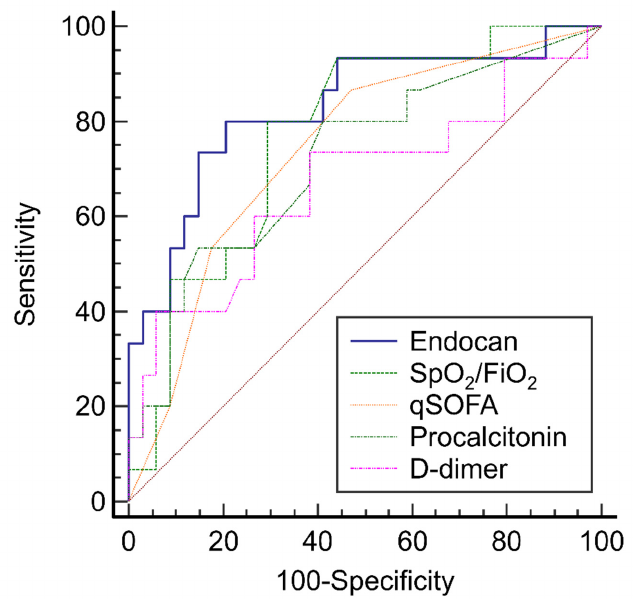
Figure 2. Comparison of ROC curves for predicting weaning failure. FiO 2 : fraction of inspired oxygen; SpO 2 : pulse oximetric saturation; qSOFA: quick Sequential Organ Failure Assessment; ROC: receiver operating characteristic curve.